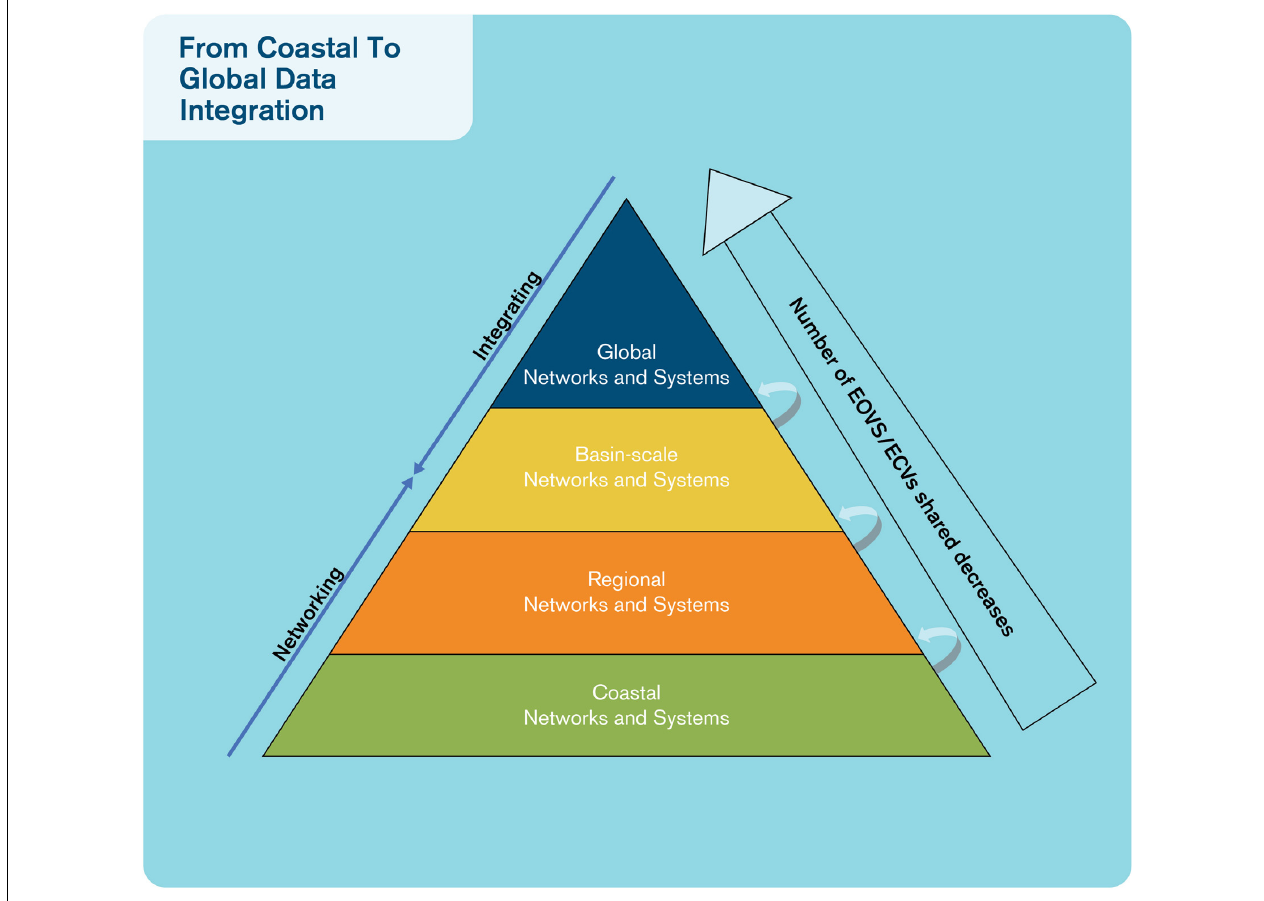
FIGURE 6 | From coastal to global data integration. For data to be made most accessible and used most efficiently, all data management systems must be interoperable, and data must be made available from central data repositories.